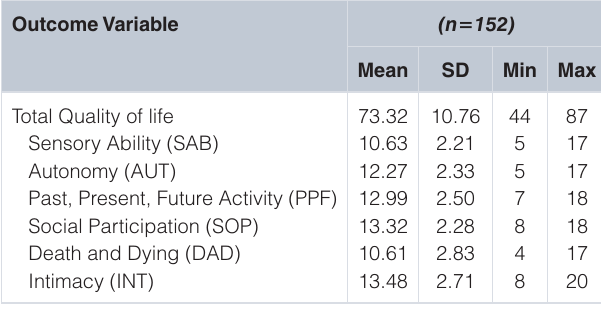
Table 3. Mean and standard deviation of quality of life among elderly people (n = 152).